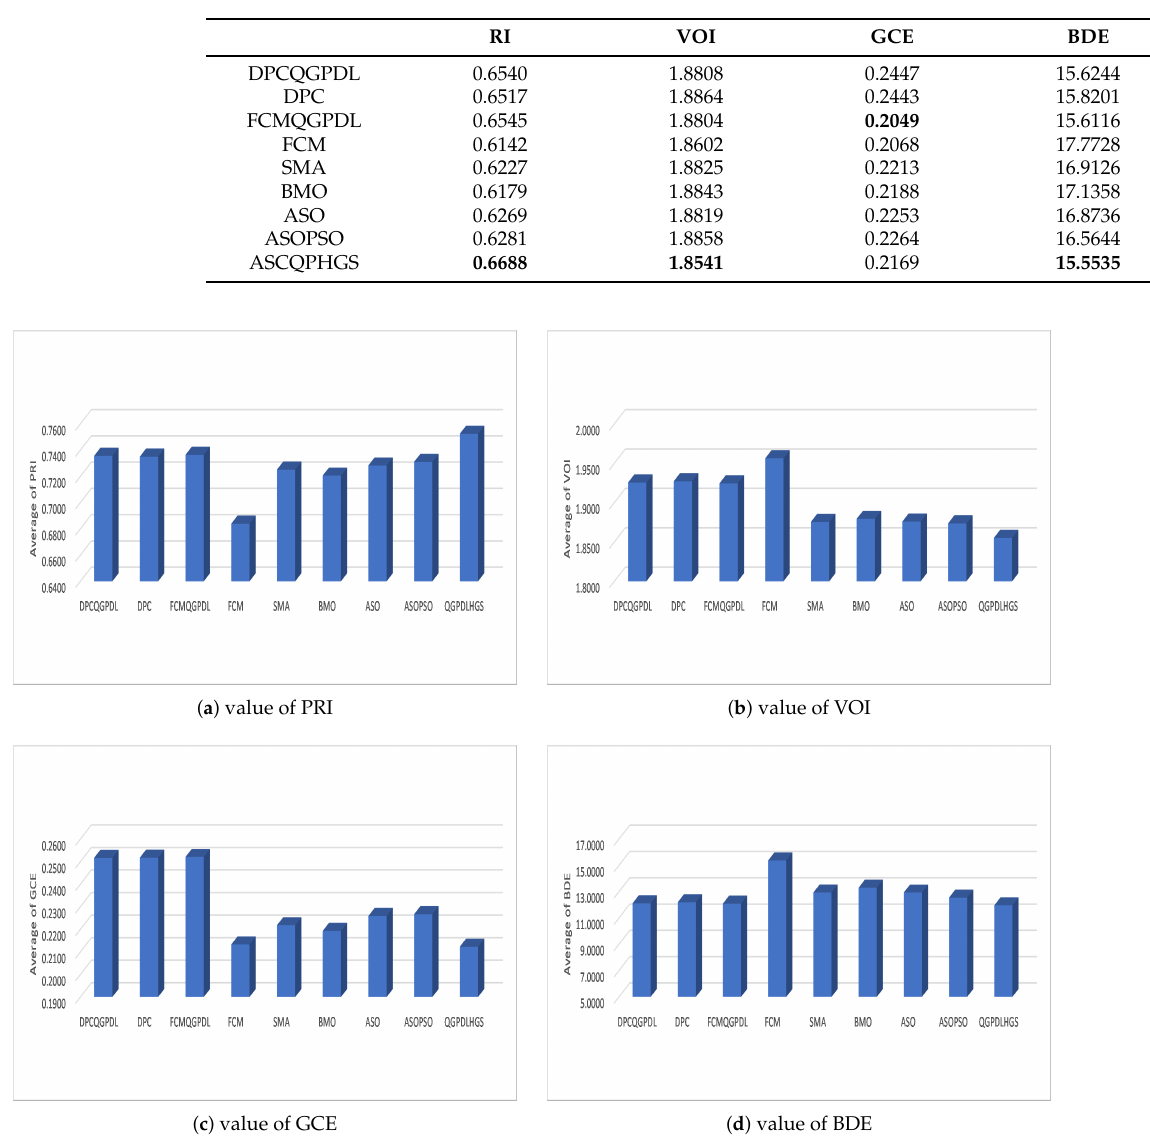
Table 2. Results of competitive techniques for the SBD.